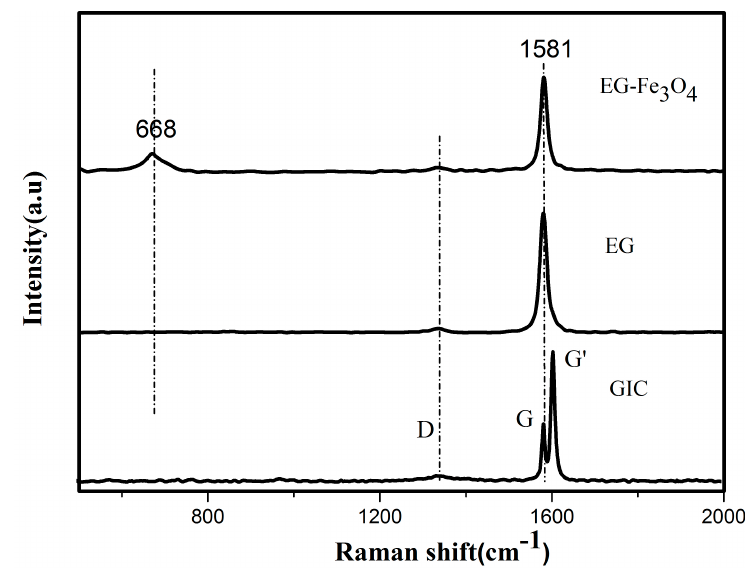
Figure 5. Raman spectra of graphite, graphene intercalation compounds (GIC), EG and EG/ Fe 3 O 4 composite.